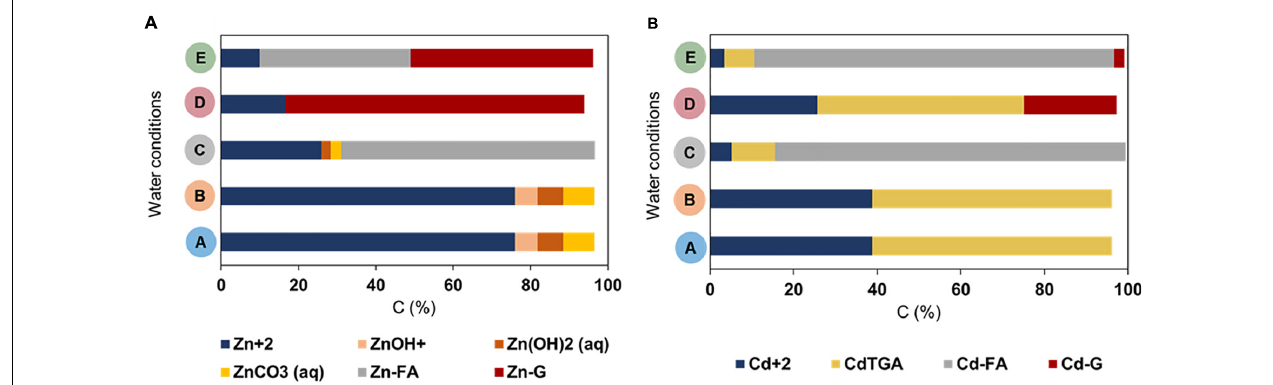
FIGURE 6 | Speciation of Zn (A) and Cd (B) by thermodynamic modeling. Conditions (A) SRW, (B) SRW-Zn, (C) SRW-Zn-FA, (D) SRW-Zn-G, and (E) SRW-Zn-FA-G.